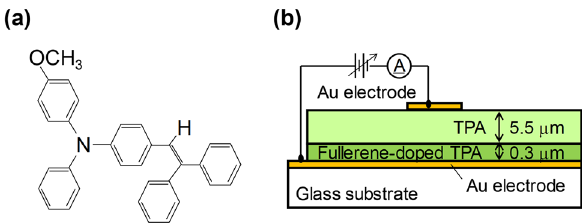
Figure 1. ( a ) Molecular structure of α-phenyl-4 ′ -[(4-methoxyphenyl)phenylamino]stilbene (TPA) and ( b ) schematic cross-section of the Au/fullerene-doped TPA/TPA/Au layered device.